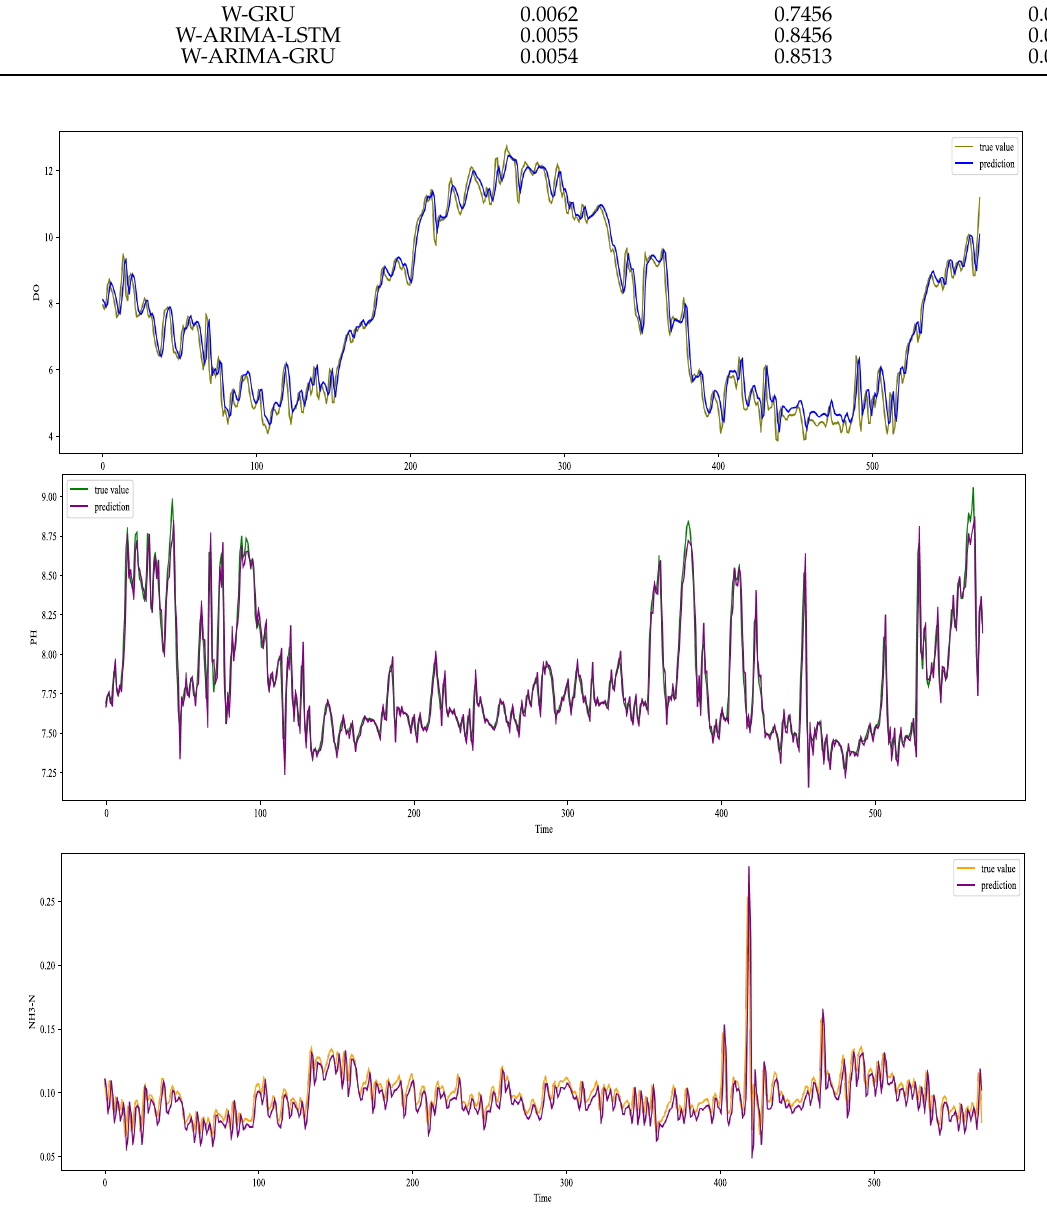
Figure 13. Fitting curve for water quality indicator data prediction. Using MAE, RMSE, and R2 values as evaluation metrics, the prediction of each model on this data set using the ablation experimental approach is shown in Table 5. The R2 values of the proposed model were 0.9828, 0.9213, and 0.8513 for the three studied sub- jects, respectively, which were higher than the other models. The MAE and RMSE were also minimized accordingly. With a time-step of 30, eight comparison models were in- cluded: SVR, Temporal Convolutional Network (TCN), LSTM, ARIMA, GRU, Wavelet- LSTM (W-LSTM), Wavelet-GRU (W-GRU), and Wavelet-ARIMA-LSTM (W-ARIMA- LSTM). The proposed model exhibited good results.